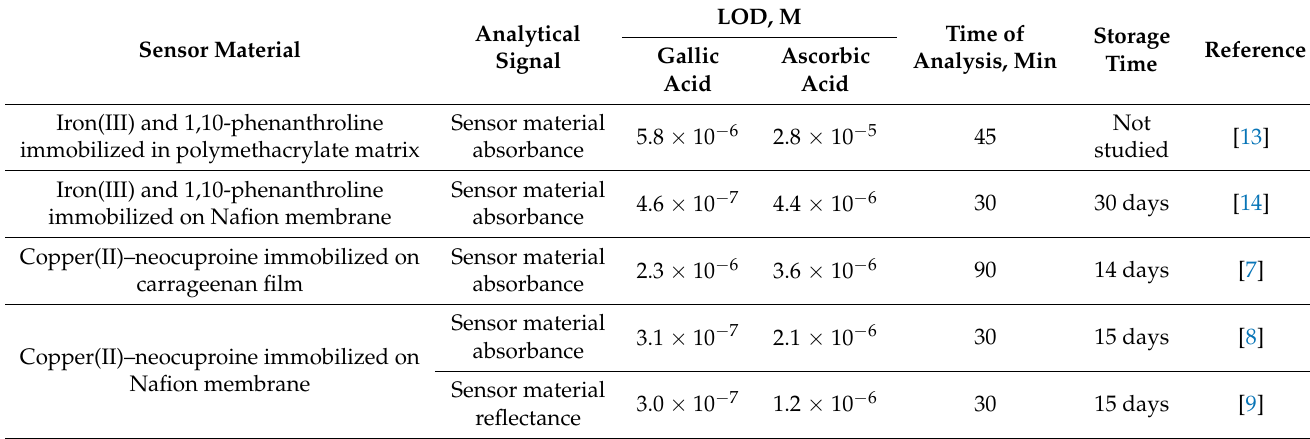
Table 6. Comparison for solid phase spectroscopic procedures for TAC determination.